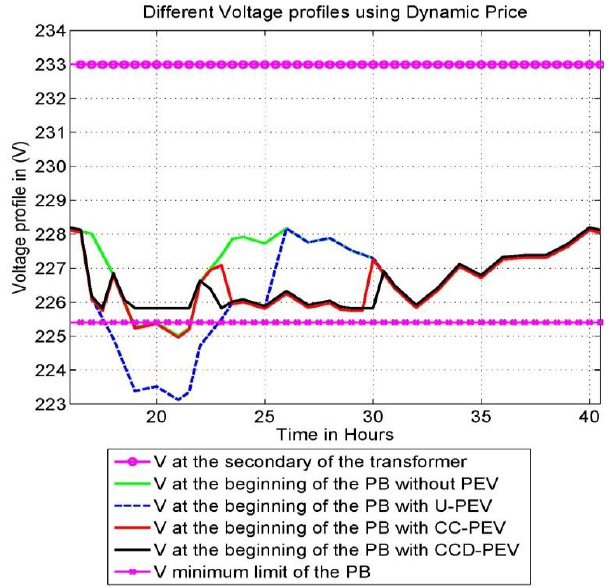
Figure 6. Voltage profiles at home.